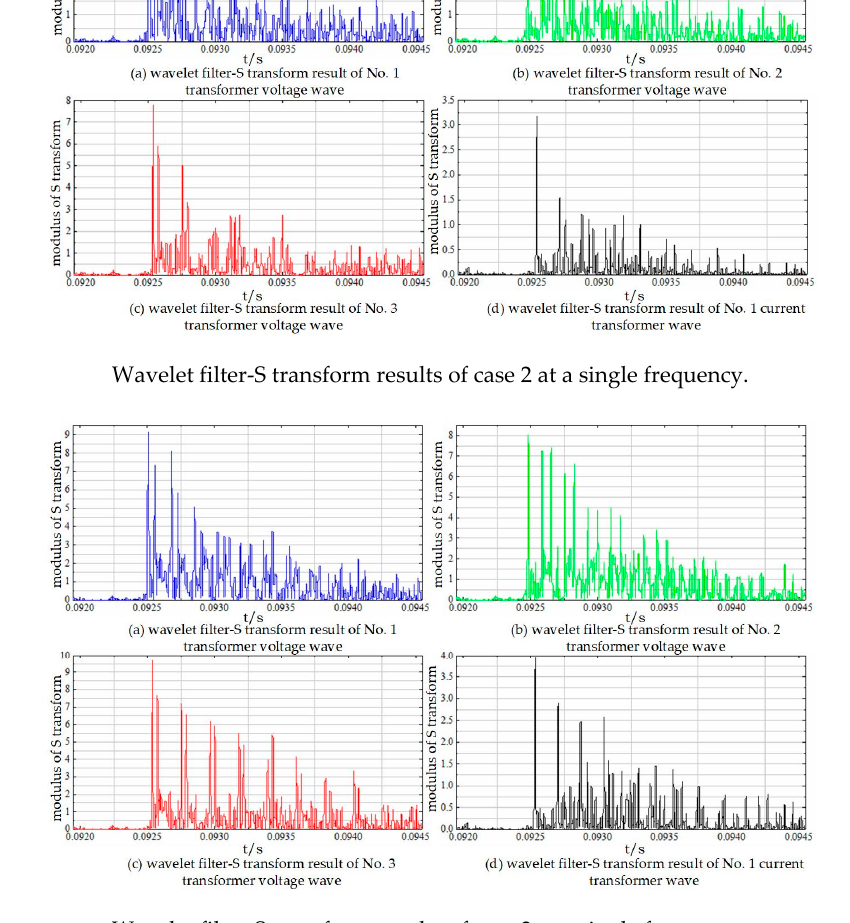
Figure 11. Wavelet filter-S transform results of single frequency in different conditions.